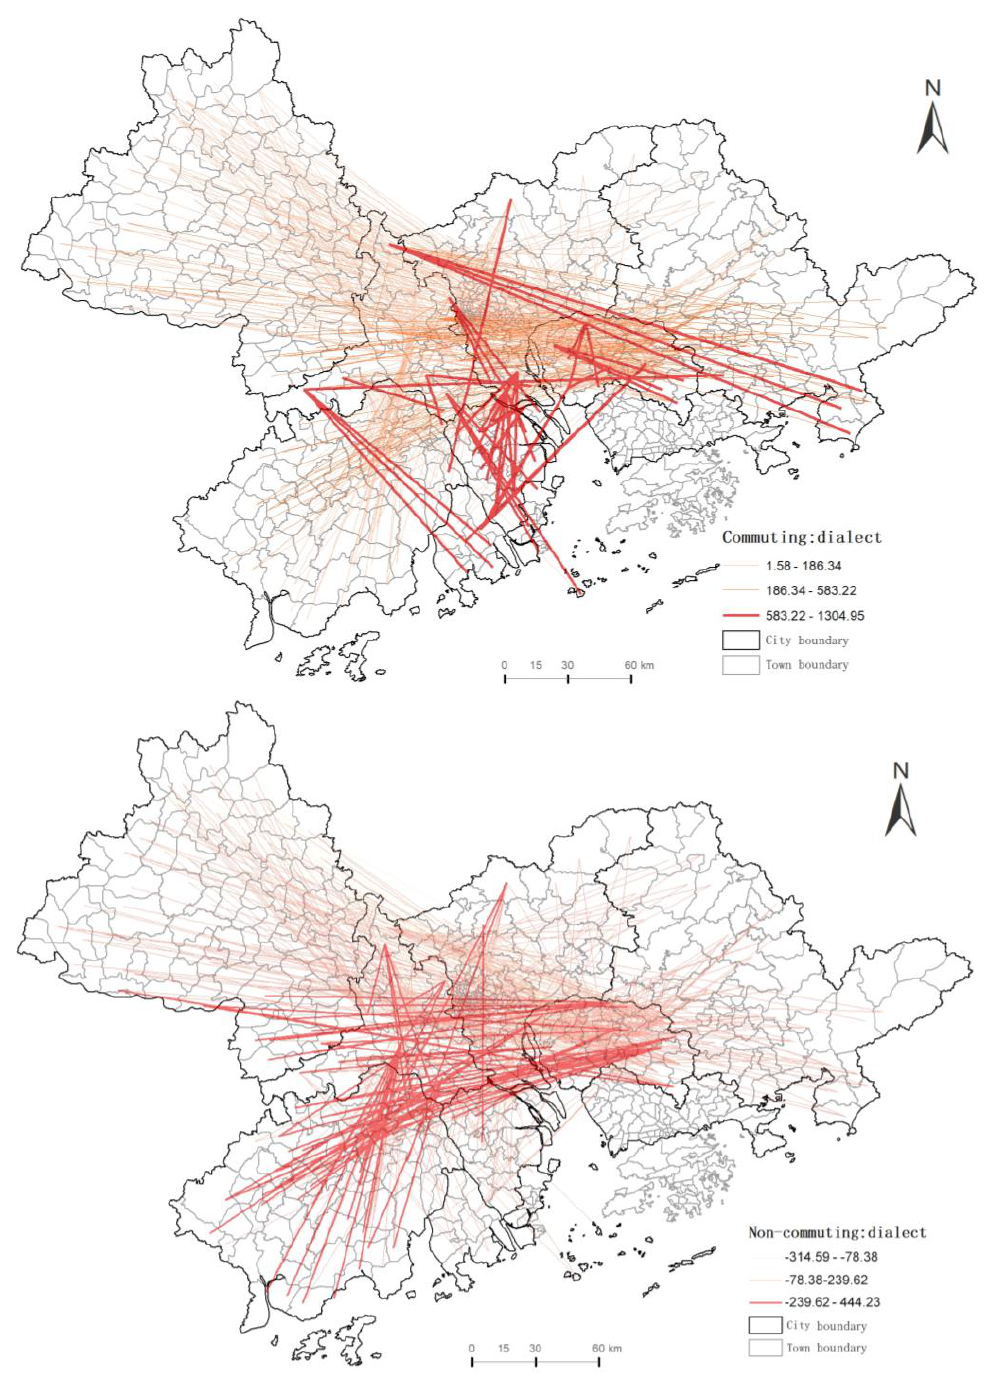
Figure 4. The local effect of dialect on rural